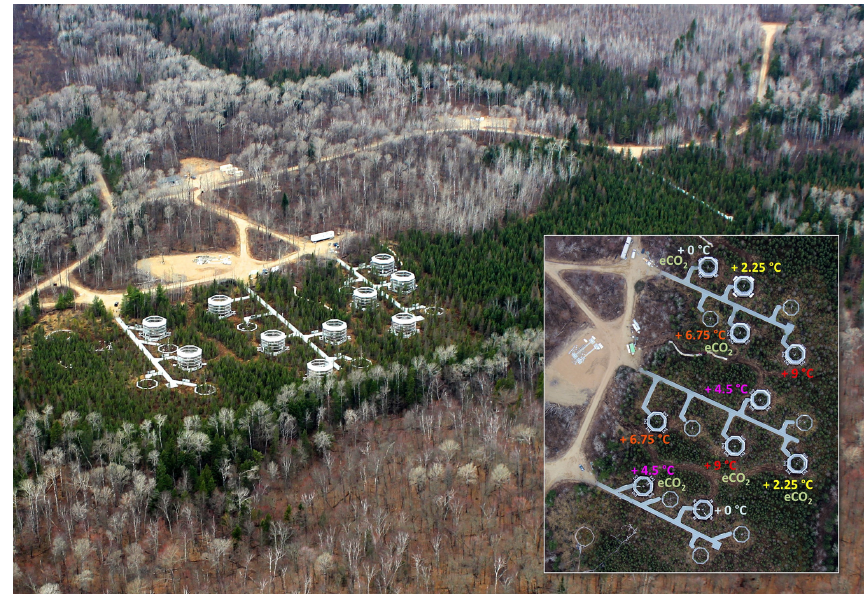
Figure 1. Aerial view of the S1-bog within the Marcell Experimental Forest and the SPRUCE experimental footprint in April 2015.